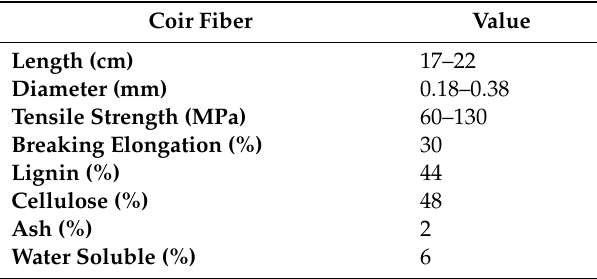
Table 2. Properties of the coir fiber used in this study [17].